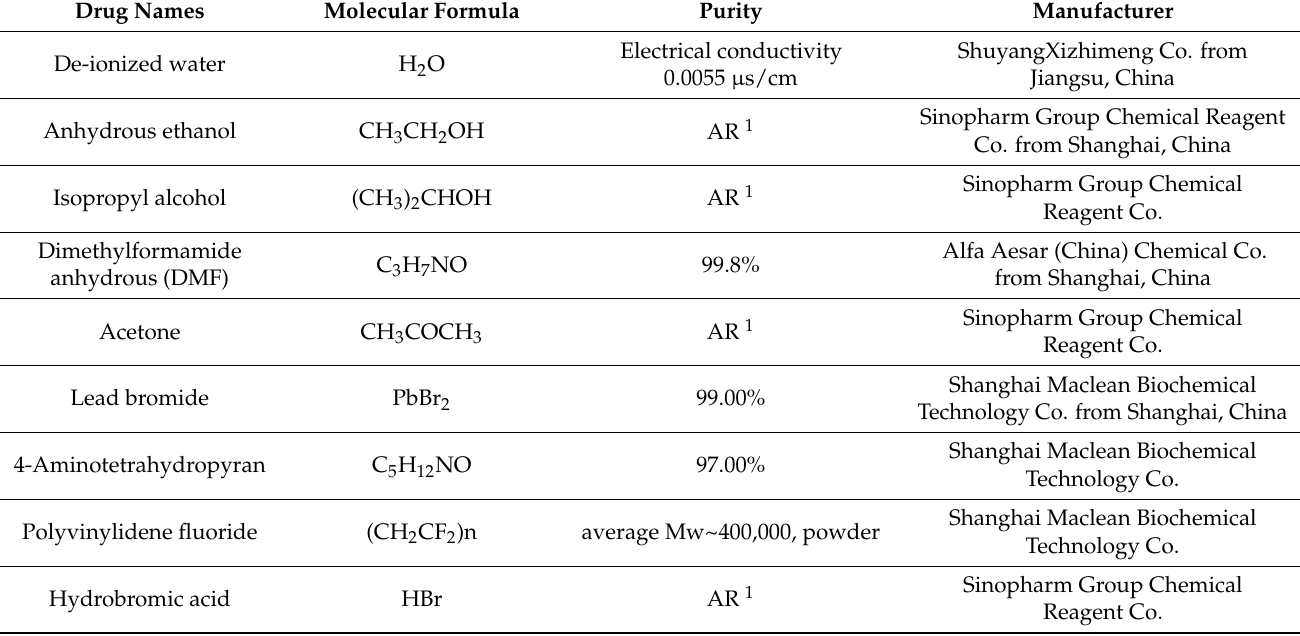
Table 1. Experimental use of